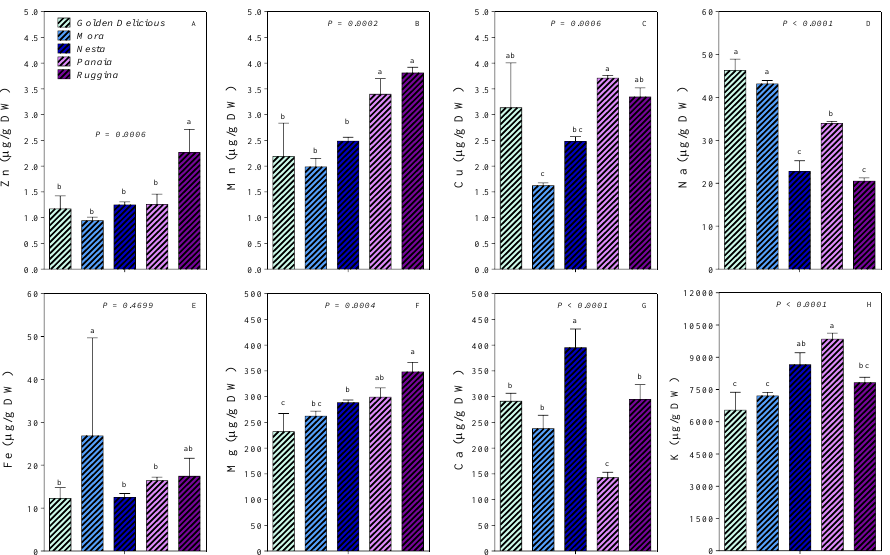
Figure 3. Concentrations of ( A ) Zn, ( B ) Mn, ( C ) Cu, ( D ) Na, ( E ) Fe, ( F ) Mg, ( G ) Ca and ( H ) K (μg g −1 of dry weight), in the different apple cultivars. Data ( n = 3) were analyzed by one-way ANOVA. Tukey’s post-hoc test at 0.05 probability level was applied and different letters indicated significant difference among means.